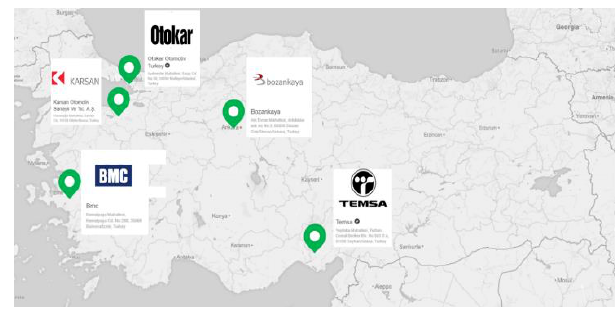
Fig. 3. E-bus manufacturers in Turkey [11].